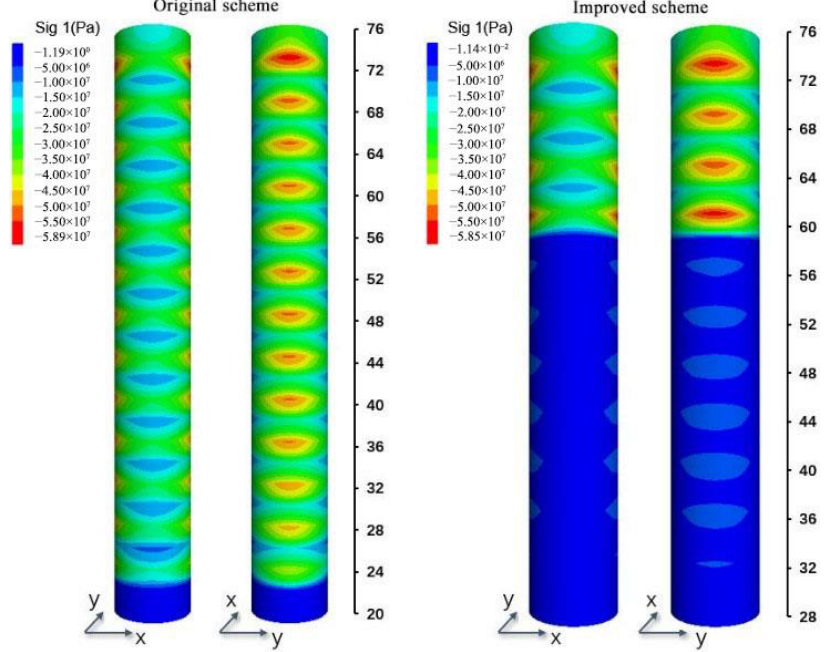
Figure 16. Major principal stress on the lining.